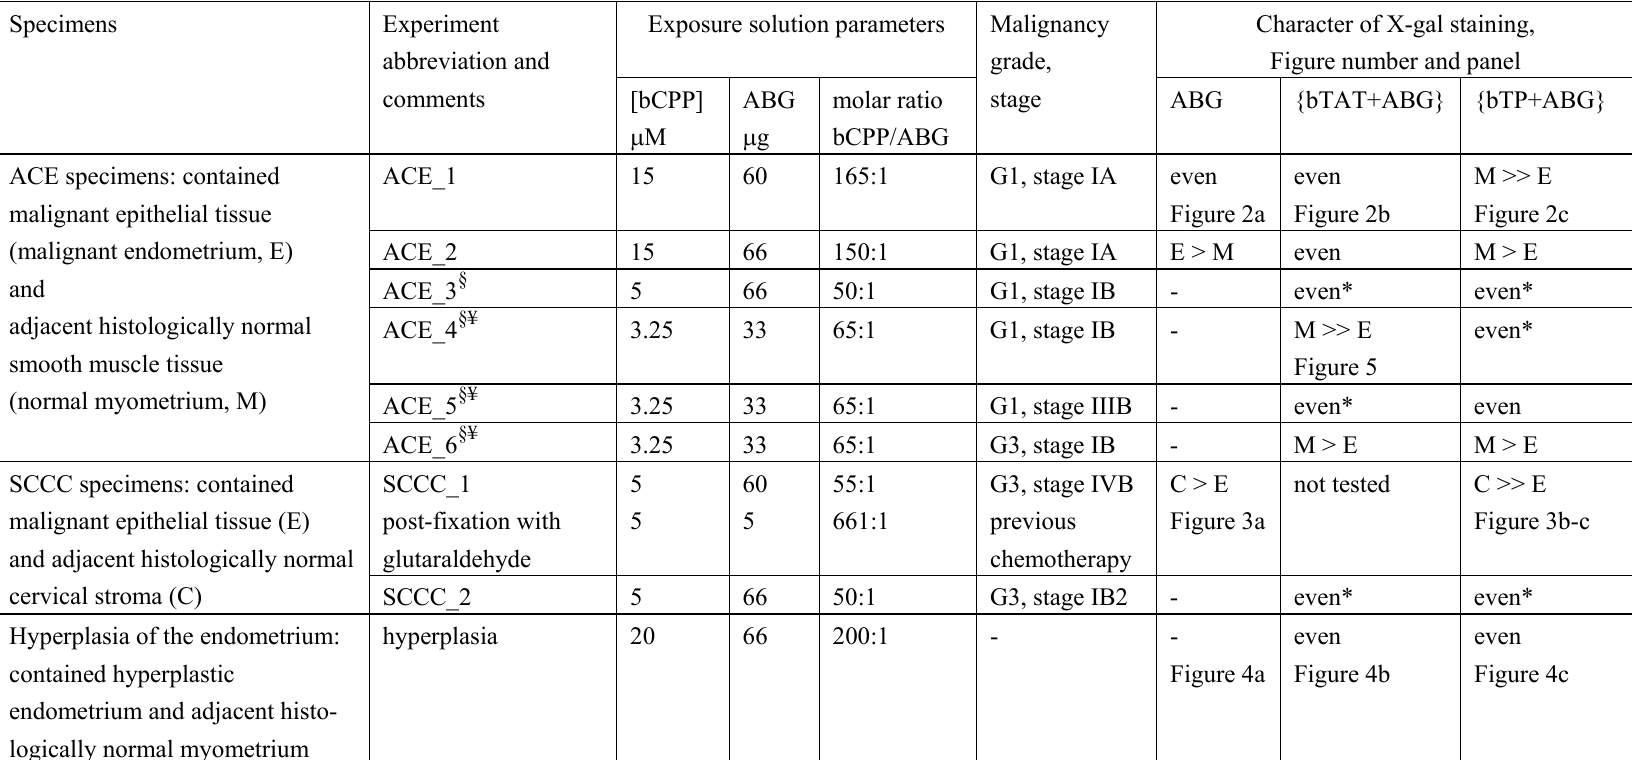
Table 1. Results from the tissue-dipping